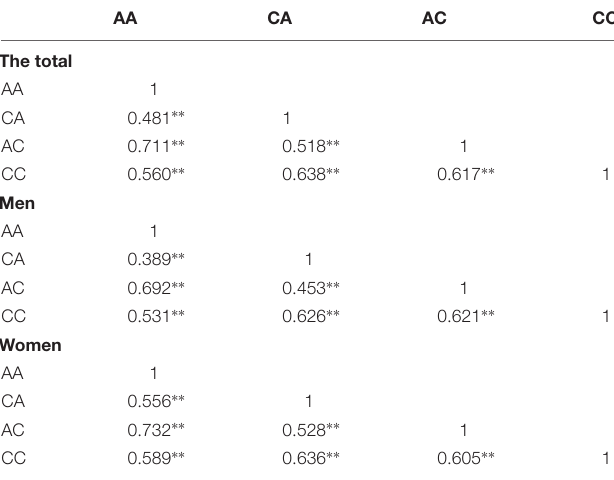
TABLE 4 | Correlations between factors in the total sample and sub